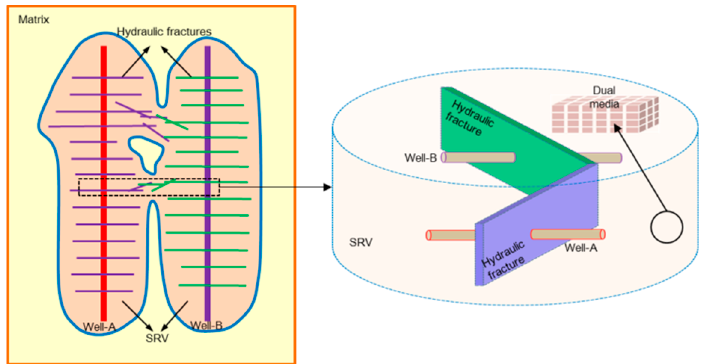
Figure 1. Multi-region coupled shale reservoir physical model (Well-A and well-B are two multi-stage fracturing horizontal wells (MFHWs), the hydraulic fractures connected with the SRV and the SRVs are dual medium.).